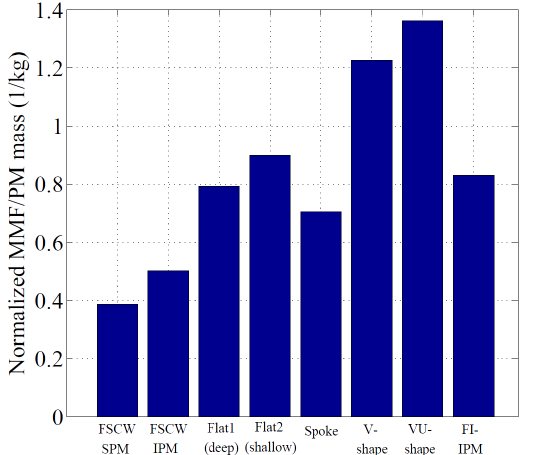
Figure 6. Demagnetization index representing normalized demagnetizing MMF per unit magnet mass.